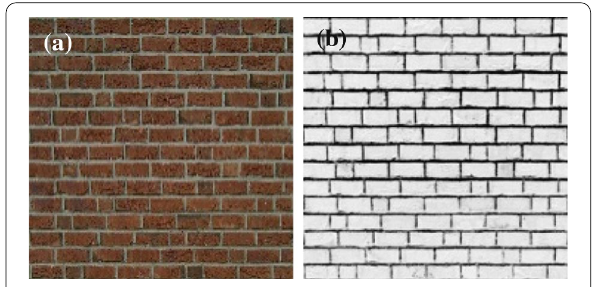
Figure 7 Conversion of texture into a greyscale